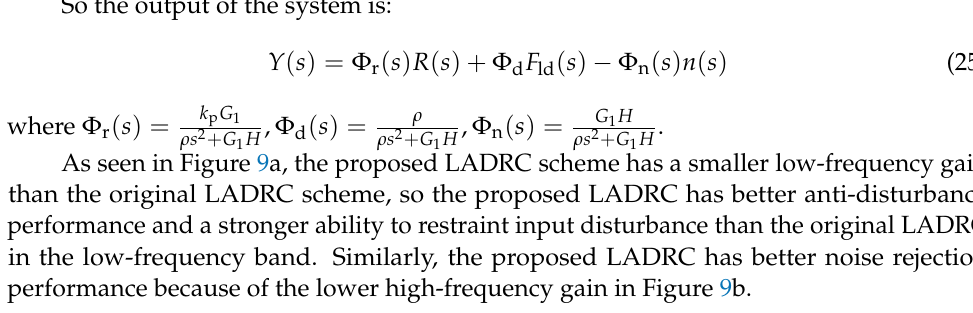
Figure 8. Simplified structure of the proposed LADRC scheme.